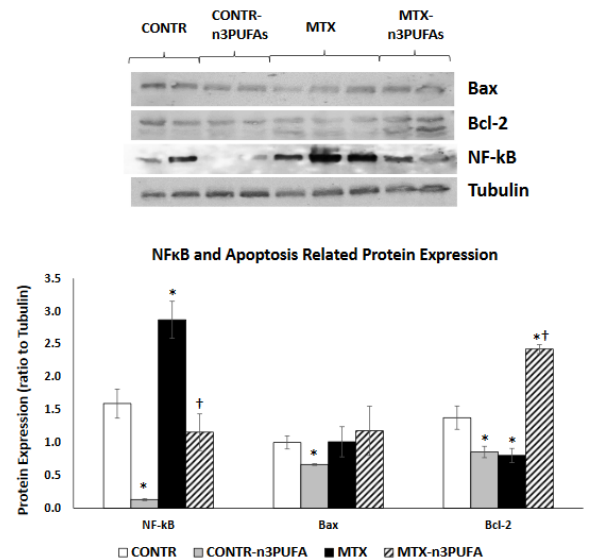
Figure 6. Changes in intestinal mucosal NF- κ B, Bax and Bcl-2 protein levels following methotrexate induced intestinal damage and treatment with n-3 PUFAs. Values are mean ± SEM. CONTR-control, MTX-methotrexate, n-3 PUFAs. * p < 0.05 all groups vs. CONTR rats, † p < 0.05 MTX-n-3 PUFAs vs. MTX rats.